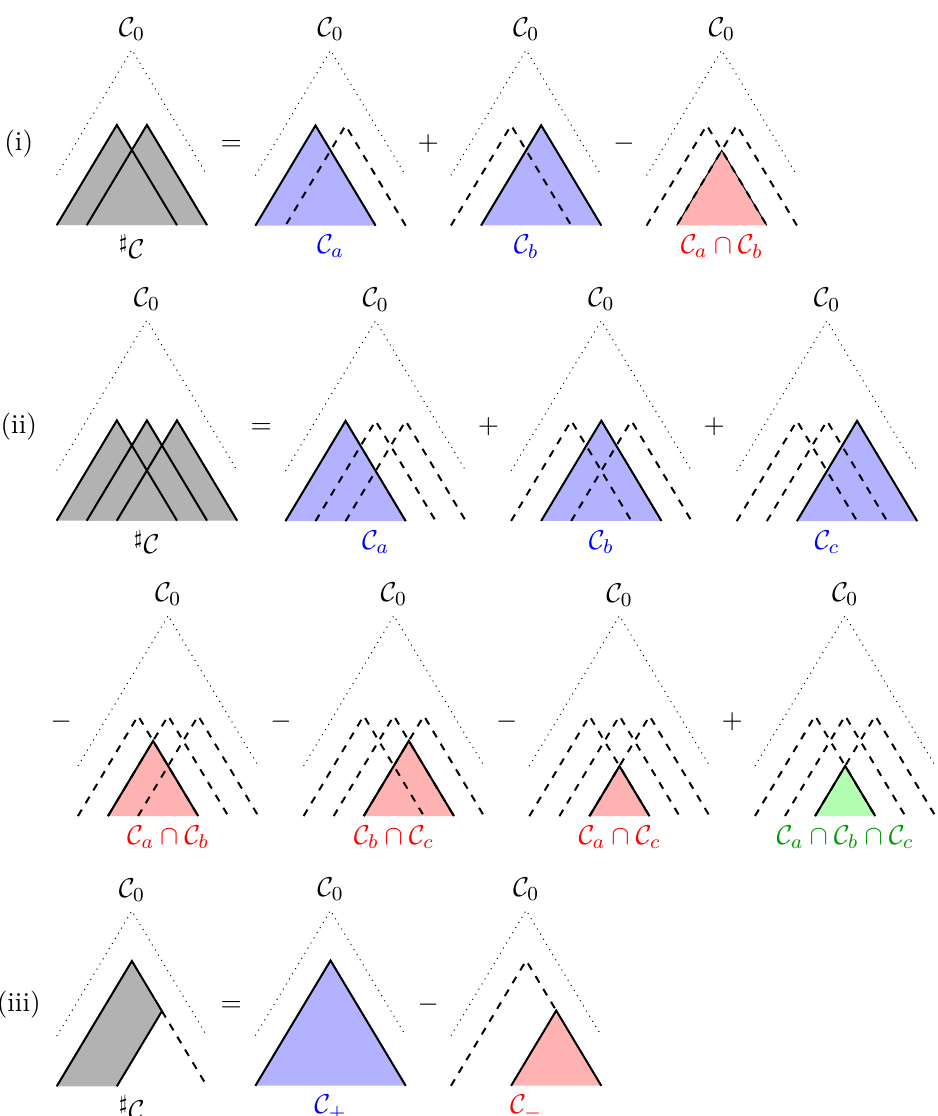
Figure 2 . The subcrystal ] C of the canonical crystal can be represented as a superposition of positive/negative canonical